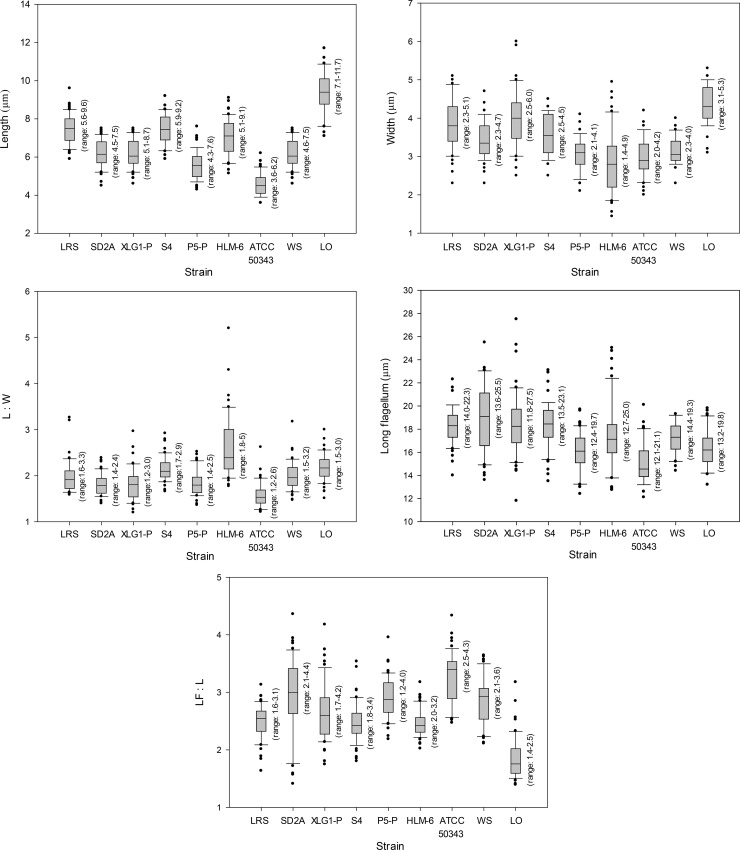
Morphometric data of Percolomonas strains analyzed in this study (n = 50).L:W: ratio of length and width of the cells, LF:L: ratio of long flagellum and length of the cells. Note that whiskers above and below the box plot (interquartile range) indicate the 90th and 10th percentiles. The individual marks (i.e. closed circles) and lines within the boxes represent each outlier outside the whiskers and the medians, respectively.